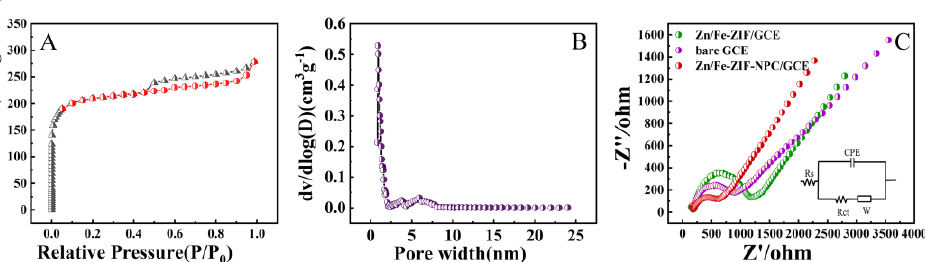
Figure 3. EDS spectrum of AuNPs/NiHCF-NPs/Zn/Fe-ZIF-NPC/GCE. Zn/Fe-ZIF loading volume: 8 μ L; Zn/Fe-ZIF-NPC loading volume: 8 μ L. CV cycle number of AuNPs electrodeposition: 10. The surfaces of AuNPs/NiHCF-NPs/Zn/Fe-ZIF-NPC/GCE and Apt/AuNPs/NiHCF- NPs/Zn/Fe-NPC/GCE were observed by atomic force microscopy (AFM). As shown in Figure 4, the GCE surface became rougher after the bond of aptamer. The surface rough- ness was calculated from the AFM height images using root-mean-square value (RMS) and surface area difference. The surface height of AuNPs/NiHCF-NPs/Zn/Fe-ZIF- NPC/GCE was obtained as 388.8 nm with an RMS of approximately 33.26 nm, while the surface height of Apt/AuNPs/NiHCF-NPs/Zn/Fe-ZIF-NPC/GCE increased to 412.2 nm and the surface roughness increased to 50.37 nm, which indicates that aptamers were ef- fectively immobilized on the AuNPs/NiHCF-NPs/Zn/Fe-ZIF-NPC/GCE surface.